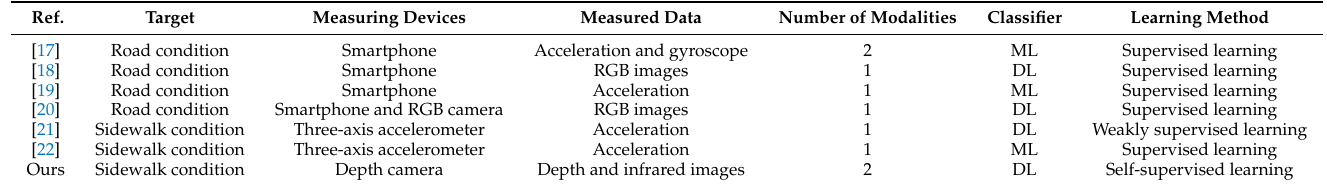
Table 7. Comparison with previous